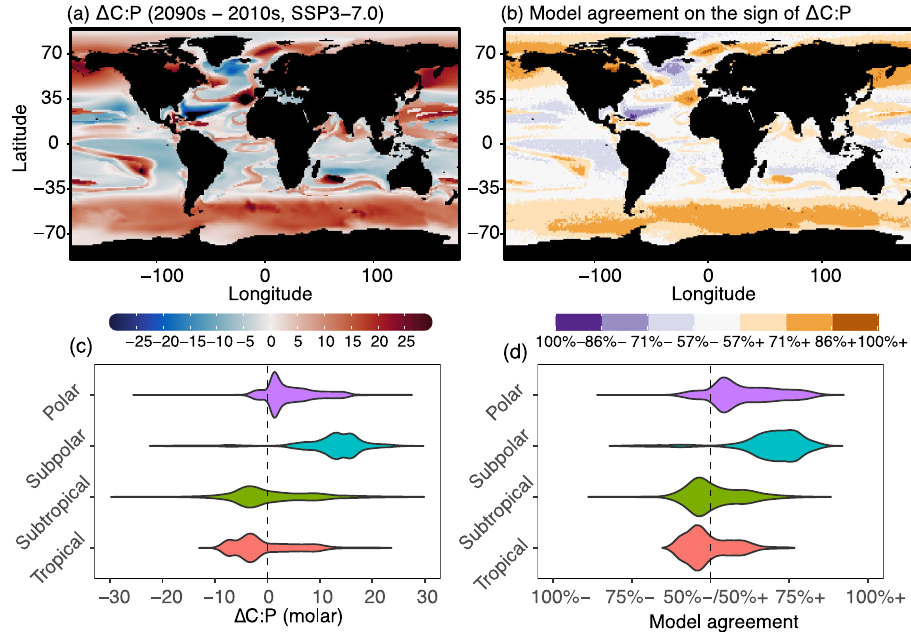
Fig. 5 Projected surface ecosystem C:P using a data-derived statistical model. a Difference in surface ecosystem C:P estimated for the 2090 s and 2010s projected using a data-derived statistical model coupled to sea surface temperature, surface nitrate concentration, nutricline, and nutrient limitation type of small phytoplankton from CESM2-LENS under the shared socioeconomic pathways SSP3-7.0 and historic scenarios, respectively. b Model agreement on the sign of change in C:P amongst 2000 randomly generated model projections based on the posterior distribution of the GAM parameters. 100% + represents the case when all 2000 models predict the positive change in C:P, and 100% represents the case when all models predict the negative change in C:P. Note that 50% + /50%- corresponds to the minimum agreement between 2000 models. Violin plots for change in c C:P and d model agreement for regions separated by latitude. Regions: Polar (|Latitude| ≥ 65°), Subpolar (45° ≤ |Latitude| < 65°), Subtropical (15° ≤ |Latitude| < 45°), and Tropical (|Latitude| <